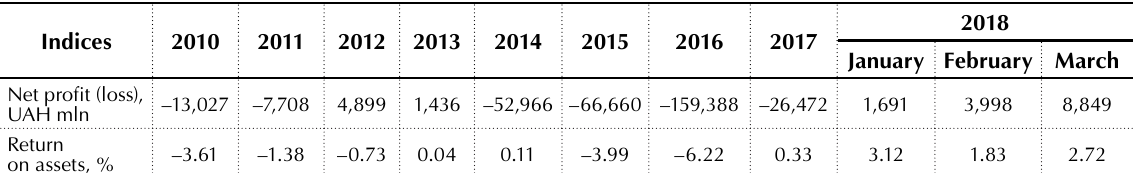
Table 2. Profitability indices of Ukrainian